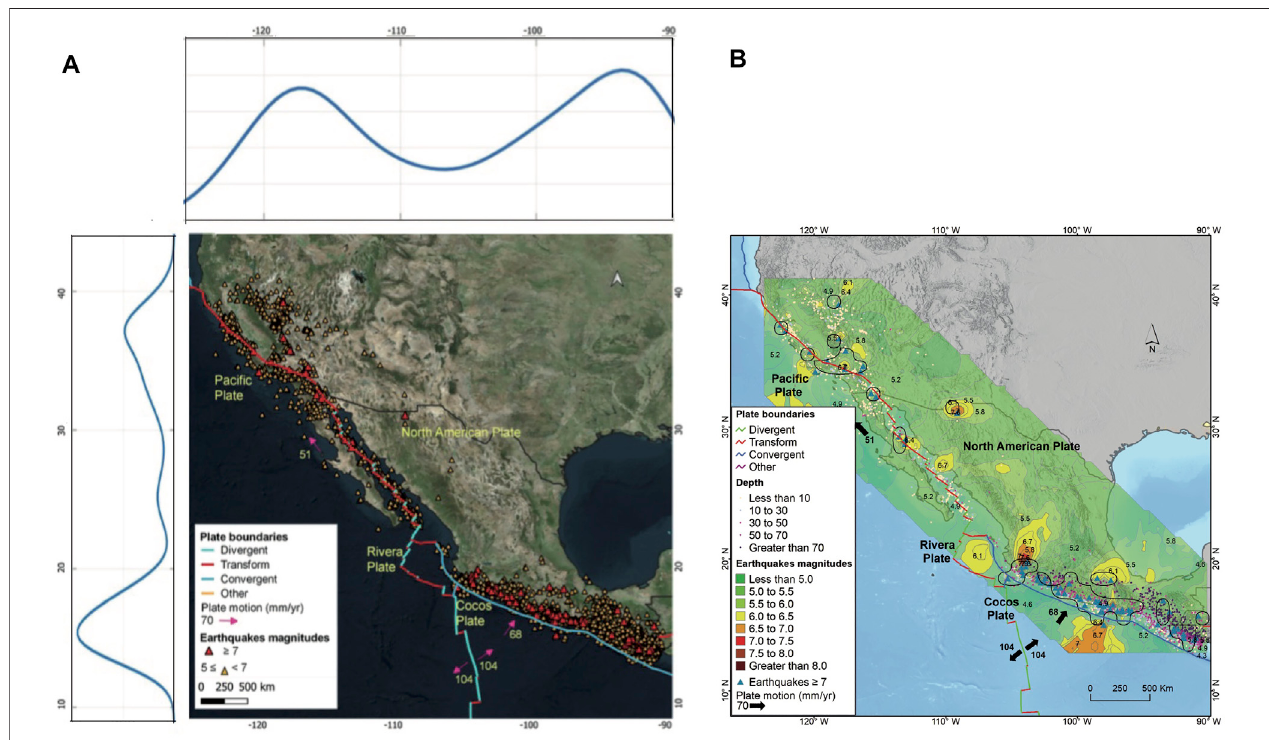
FIGURE 4 | Earthquakess in the Southwestern United States and Mexico. (A) Seismic activity between 1900 and 2021 is shown as yellow triangles for 5 ≤ earthquakesmagnitudes < 7.Earthquakesmagnitudes ≥ 7aremarkedwithredtriangles.Platemotionvectors(rotatedbasedonthedirectionofplatemovement),plate limits and earthquakes data were taken from the USGS. The PDF (probability density distribution) of the longitude and latitude shows that the seismic zones have a bimodalandtrimodaldistribution,respectively(seemaintextformoredetailsanddiscussion). (B) DistributionofseismichazardsintheSouthwesternUnitedStates and Mexico. The probabilistic spatial clustering occurrence for 5 ≤ earthquakes magnitudes < 6 is shown in shades of green; for 6 ≤ earthquakes magnitudes < 7 is shown in shades of orange; and for earthquakes magnitudes ≥ 7 is shown in shades of red.